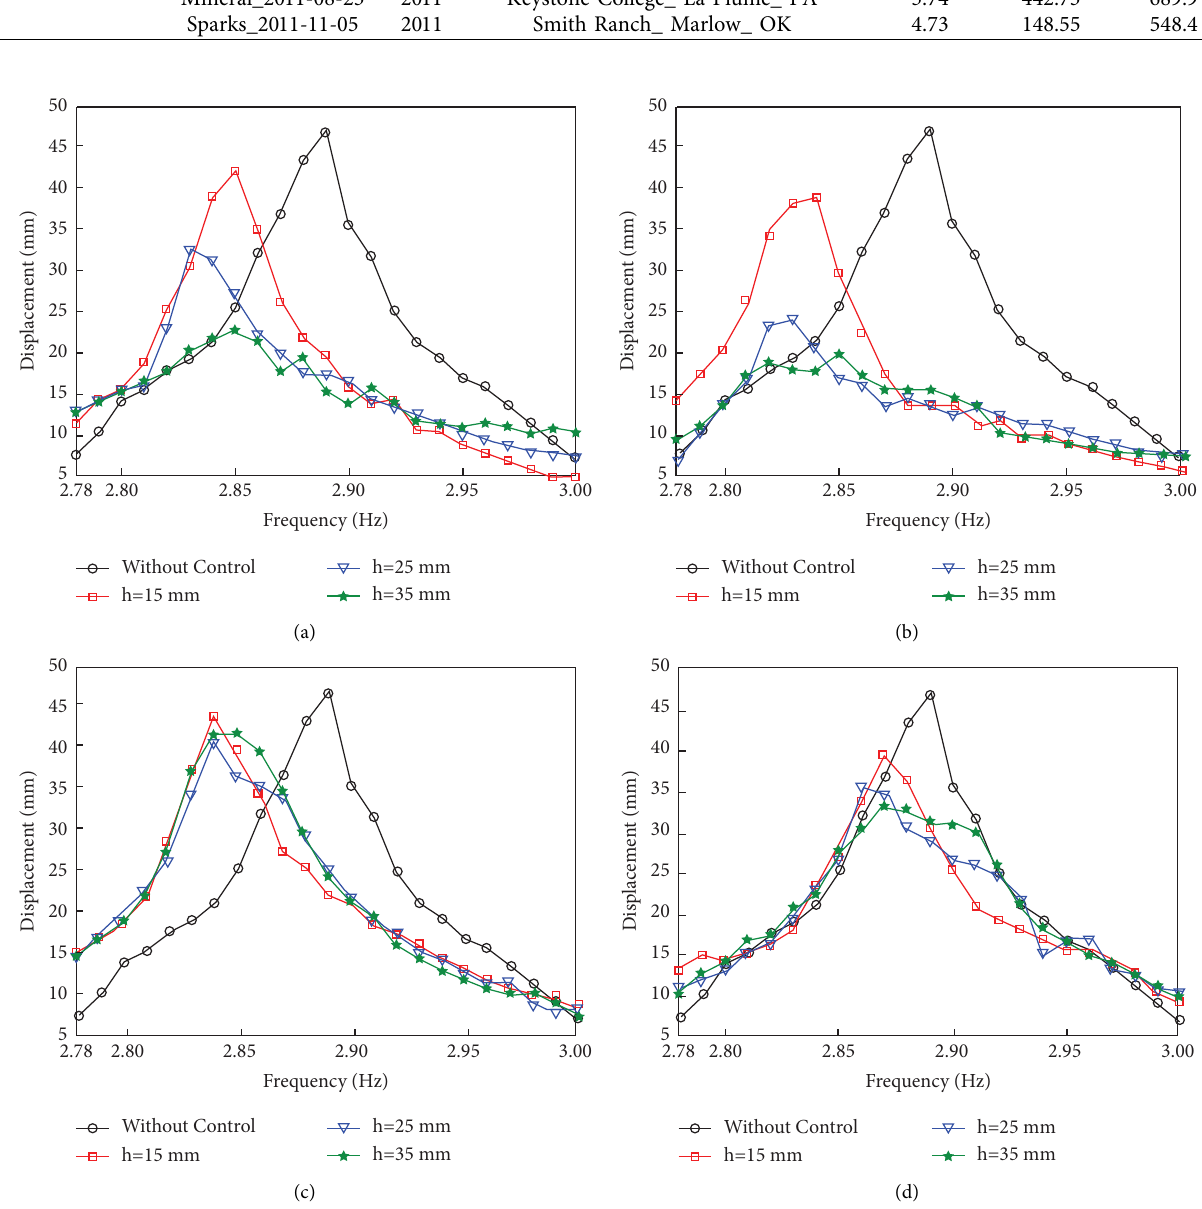
Figure 7: Frequency-displacement response of frame structure with diferent parameters: (a) δ � 0.2 mm, μ � 1.37%, (b) δ �